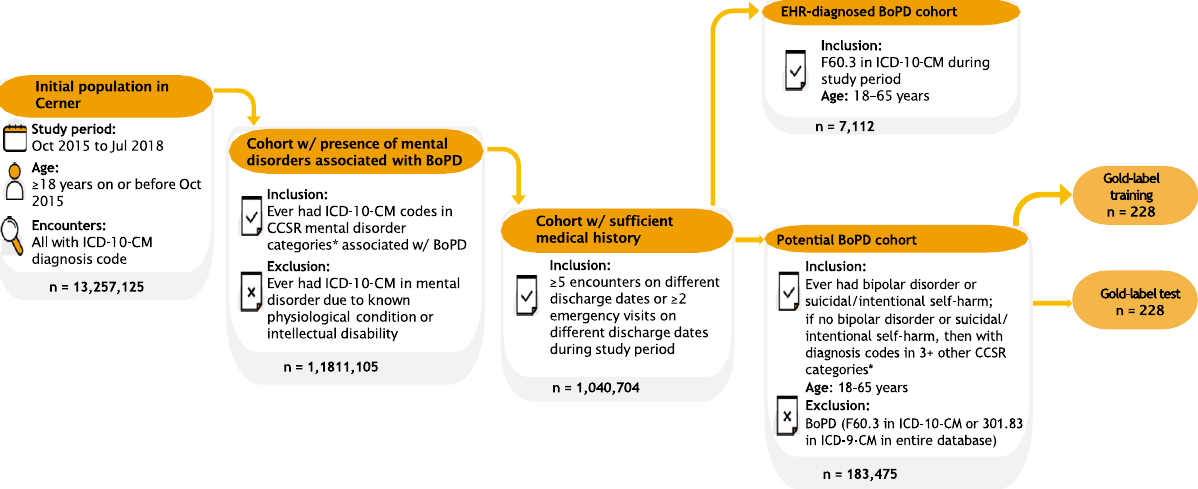
Figure 5. The flowchart of cohort selection using Cerner Health Facts data. ∗ Refer to Table 2 for CCSR mental disorder categories associated with